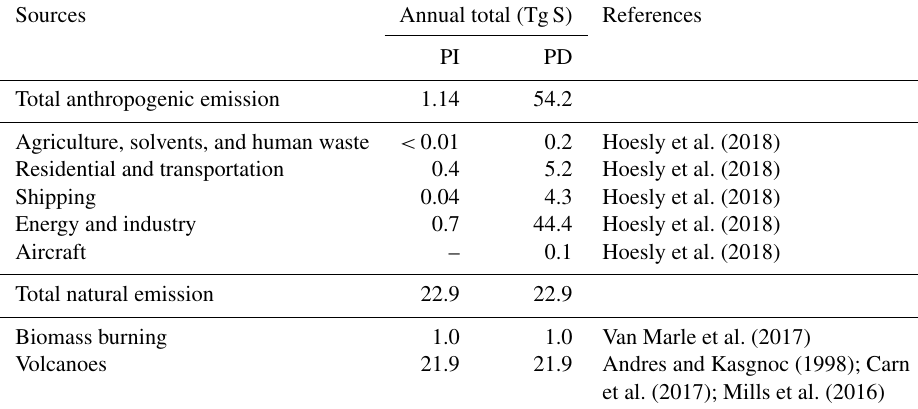
Table 2. SO 2 emissions in this study.